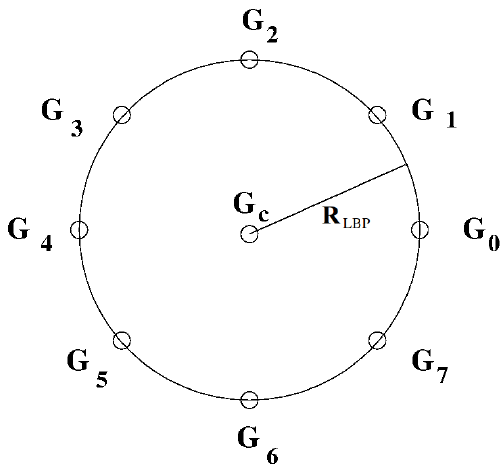
Figure 5. Geometry of an LBP with an angular step of (cid:53)/ 4. The circle has a radius of R , which is one LBP